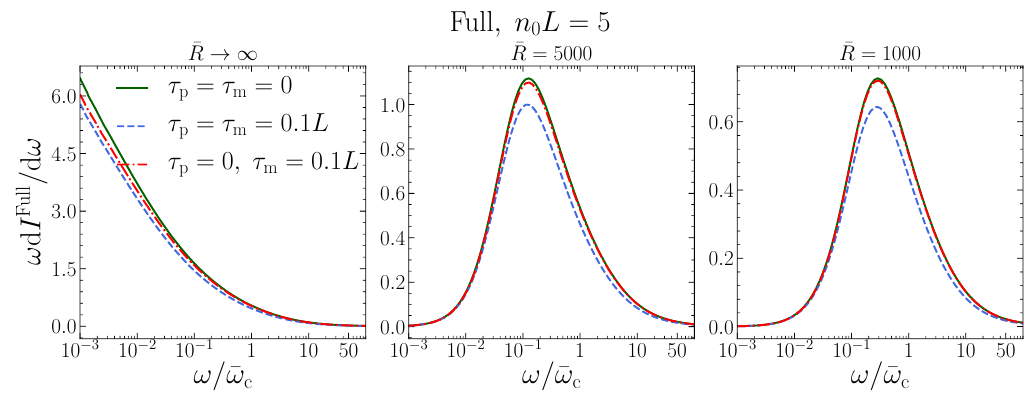
Figure 2 . Fully resummed medium-induced energy spectrum for τ p = τ m = 0 (green solid lines); τ p = τ m = 0 . 1 L (blue dashed lines); and τ p = 0 and τ m = 0 . 1 L (red dash-dotted lines) as function of ω/ ¯ ω c for n 0 L = 5 . The different panels correspond to different sets of ¯ R : ¯ R → ∞ (left), ¯ R = 5000 (central), and ¯ R = 1000